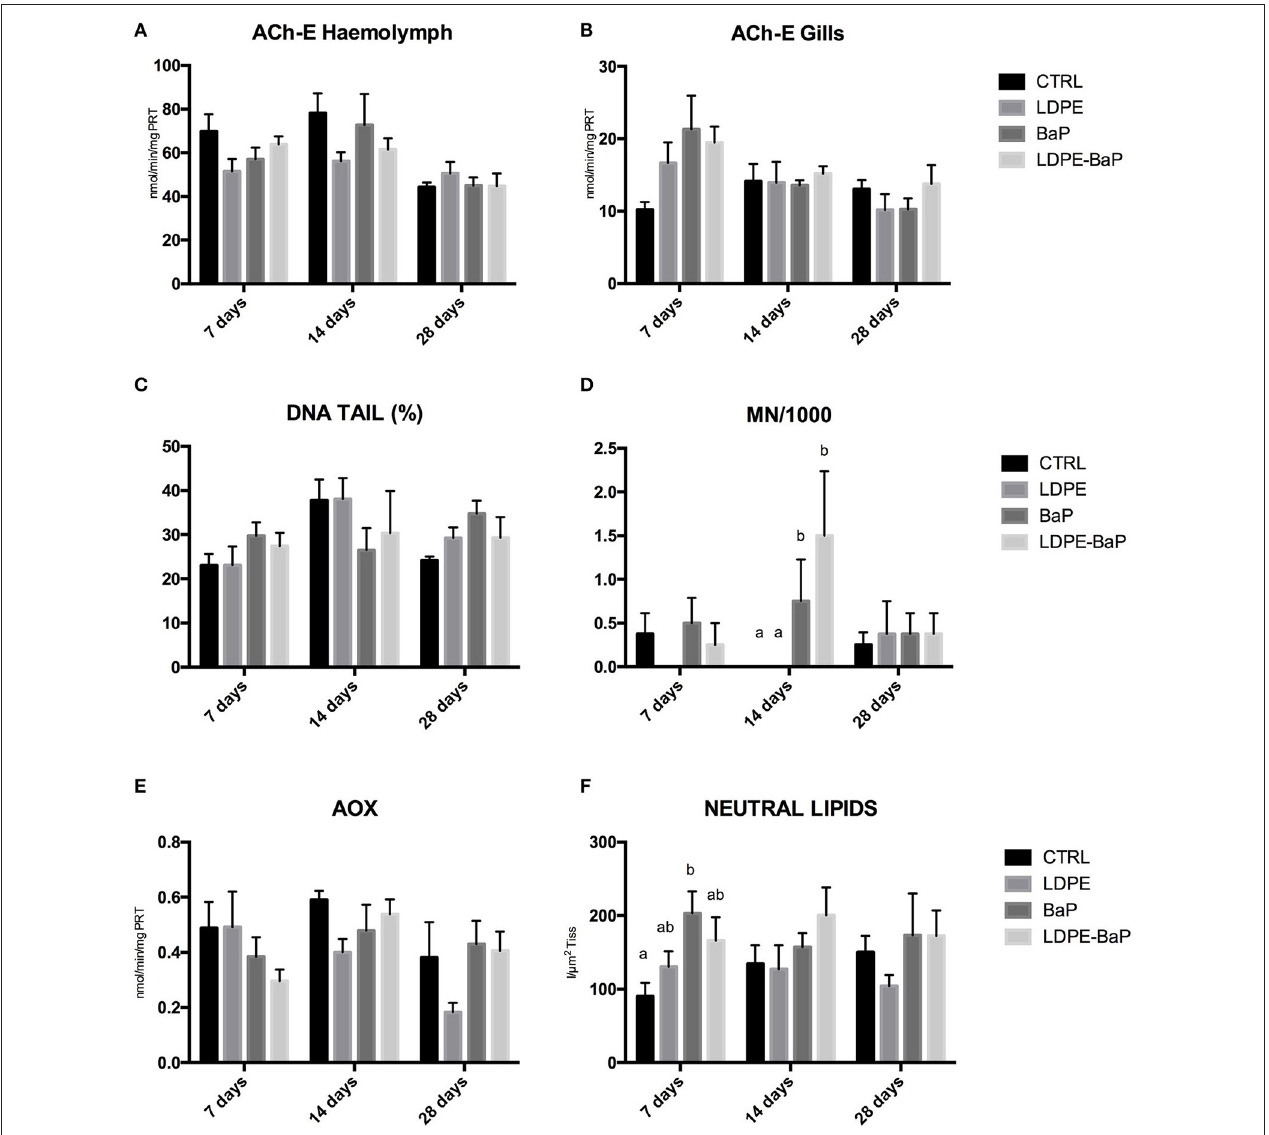
FIGURE 4 | Biomarkers in mussels exposed for 7, 14, and 28 days to various treatments (CTRL, control; LDPE, virgin low density polyethylene; BaP, benzo(a)pyrene alone; LDPE-BaP, benzo(a)pyrene-contaminated polyethylene). ACh-E: acetylcholinesterase in haemolymph (A) and gills (B) ; DNA TAIL %: fragmentation of DNA (C) ; MN/1000: frequency of micronuclei (D) ; AOX: Acyl CoA Oxidase (E) ; Neutral Lipids (F) . Data are expressed as mean values ± standard error, n = 4; different letters indicate significant differences between groups of means within the same time of exposure ( post-hoc Newman-Keuls